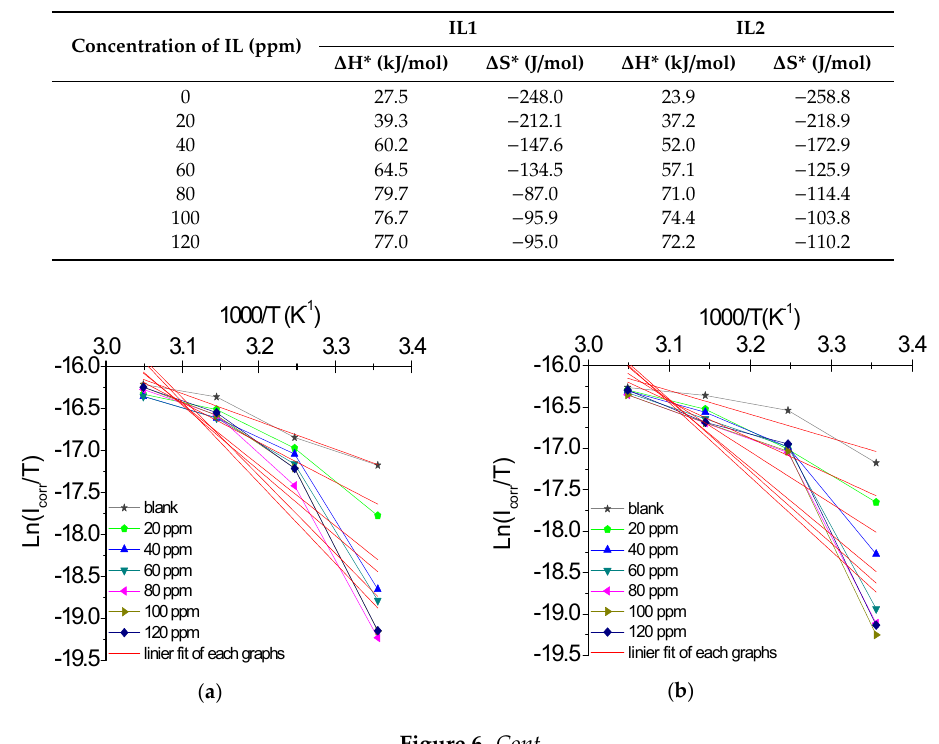
Table 6. Thermodynamic parameters of IL1 and IL2 as corrosion inhibitors on carbon steel surface in 1% NaCl.